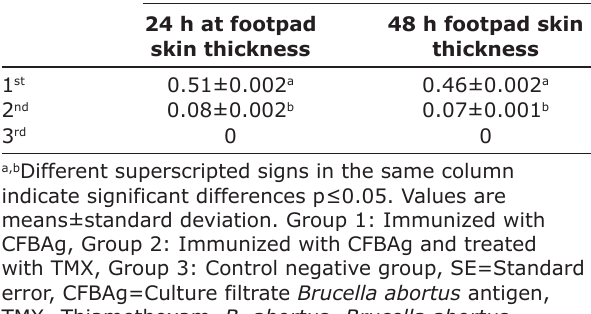
Table-1: Thickness difference of footpad skin in mice after injection I/D with B. abortus soluble antigen.